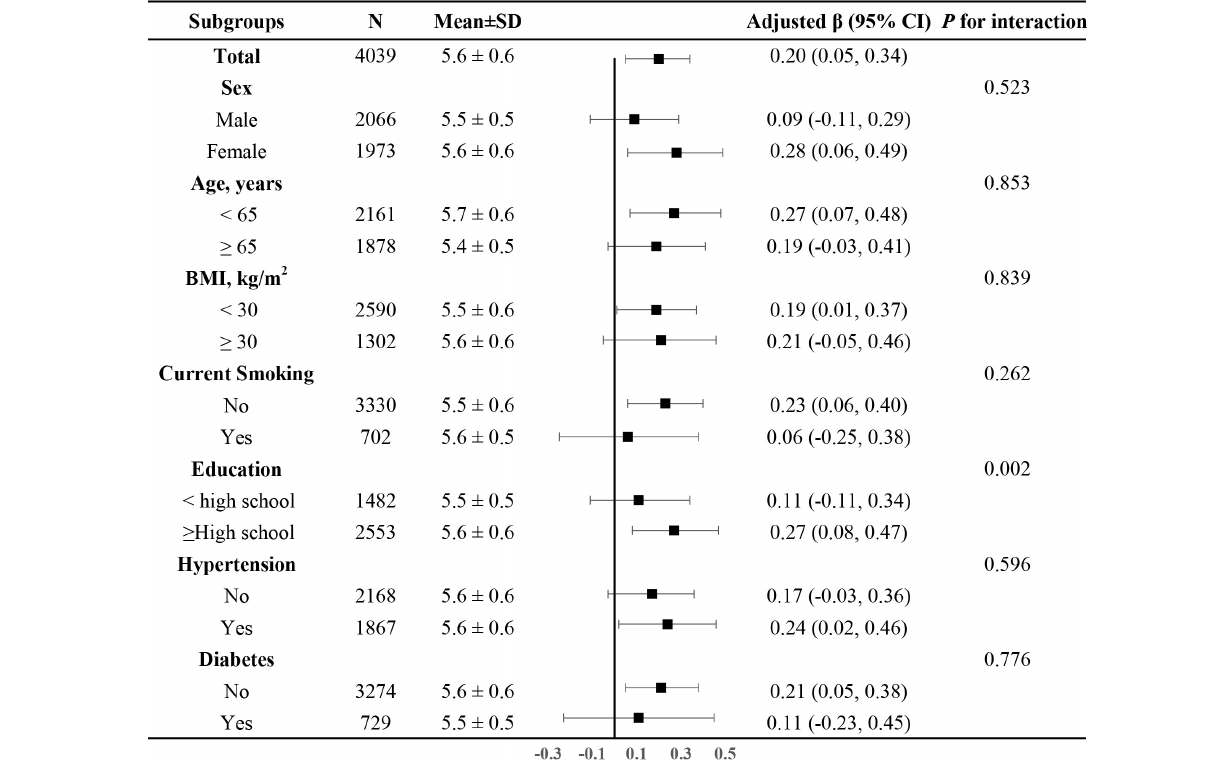
FIGURE 4 | The association between log-transformed dietary magnesium intake on leukocyte telomere length in various subgroups. Adjusted for age, sex, BMI, race, education status, smoking status, alcohol consumption, physical activity, PIR, hypertension, diabetes, TC, TG, HDL-C, FBG and sample weight, dietary fiber, and total energy intake, if not be